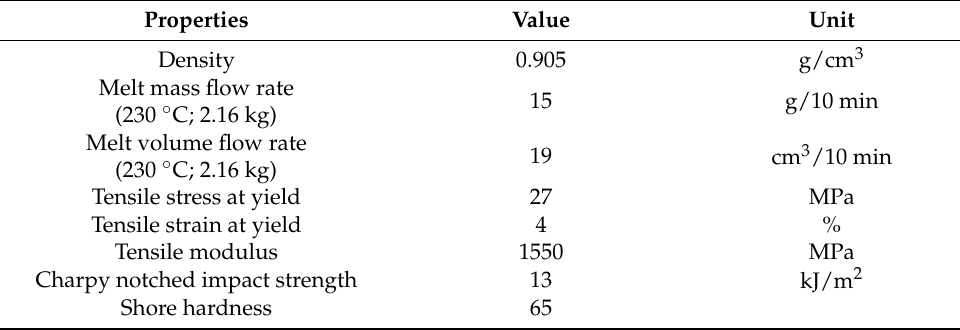
Table 1. Typical properties of SABIC ® PP CX02-82 polypropylene copolymer.